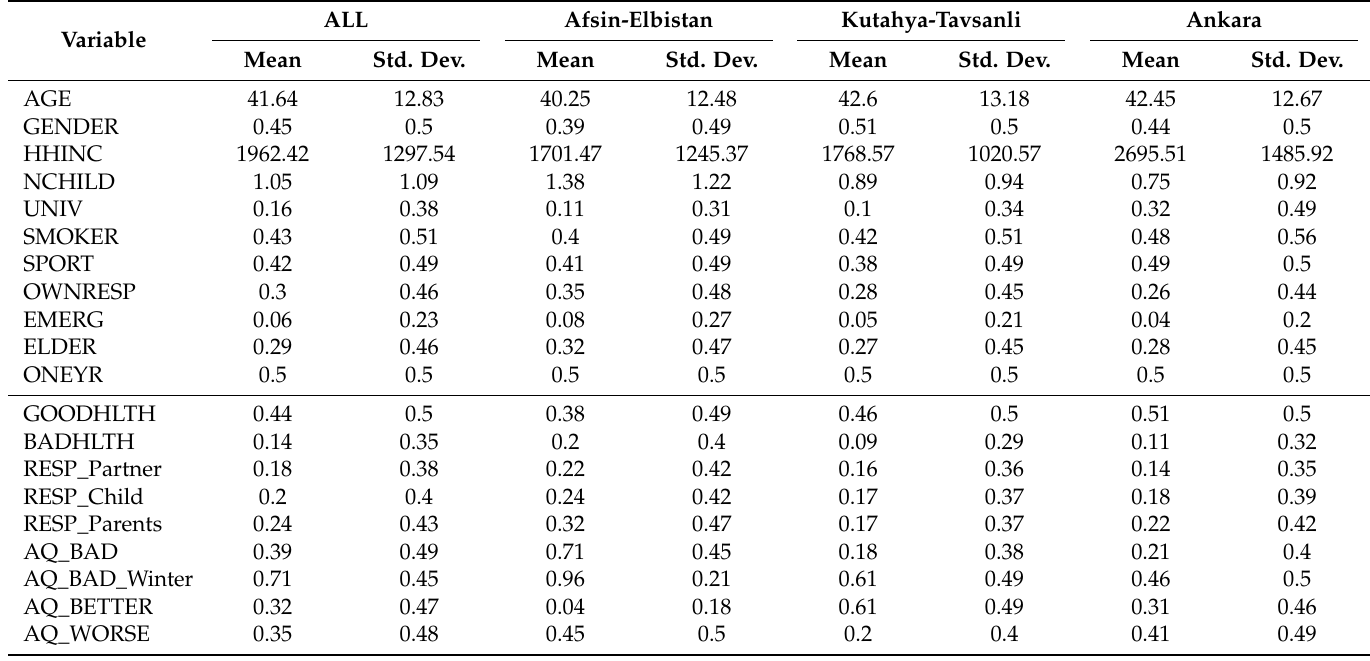
Table 4. Descriptive statistics of